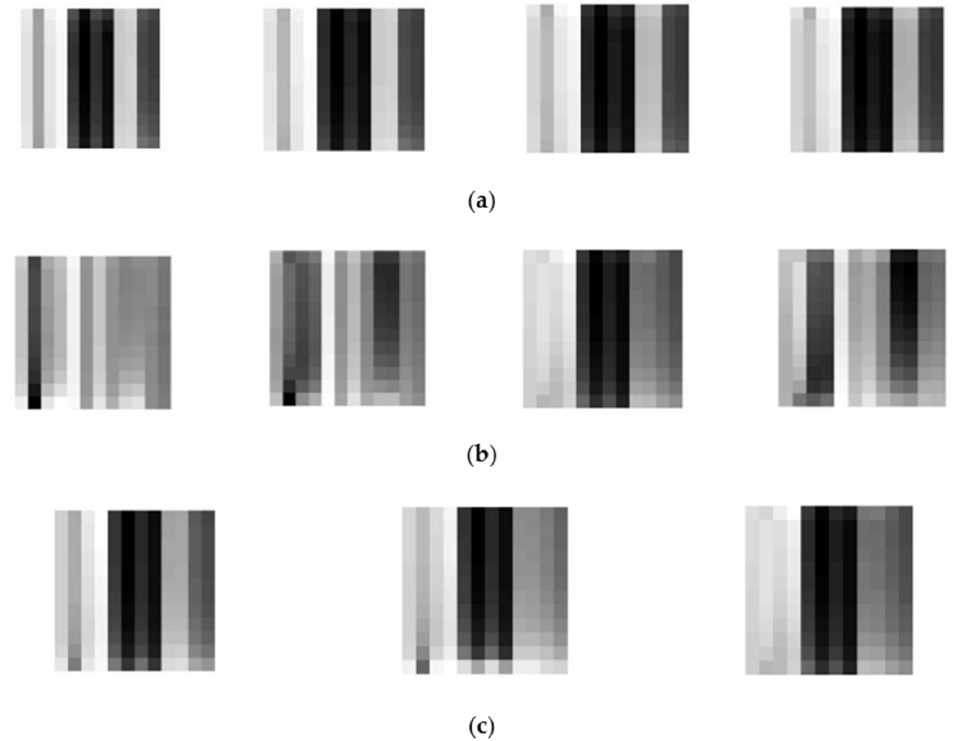
Figure 7. ( a ) Patterns of CH 4 data matrices with size 12 × 12 (500, 1000, 1500, 2000 pm); ( b ) Patterns of CO data matrices with size 12 × 12 (50, 100, 150, 200 pm); ( c ) Patterns of mixture data matrices with size 12 × 12 (500 ppm CH 4 + 50 ppm CO, 500 ppm CH 4 + 100 ppm CO, 500 ppm CH 4 + 150 ppm CO).